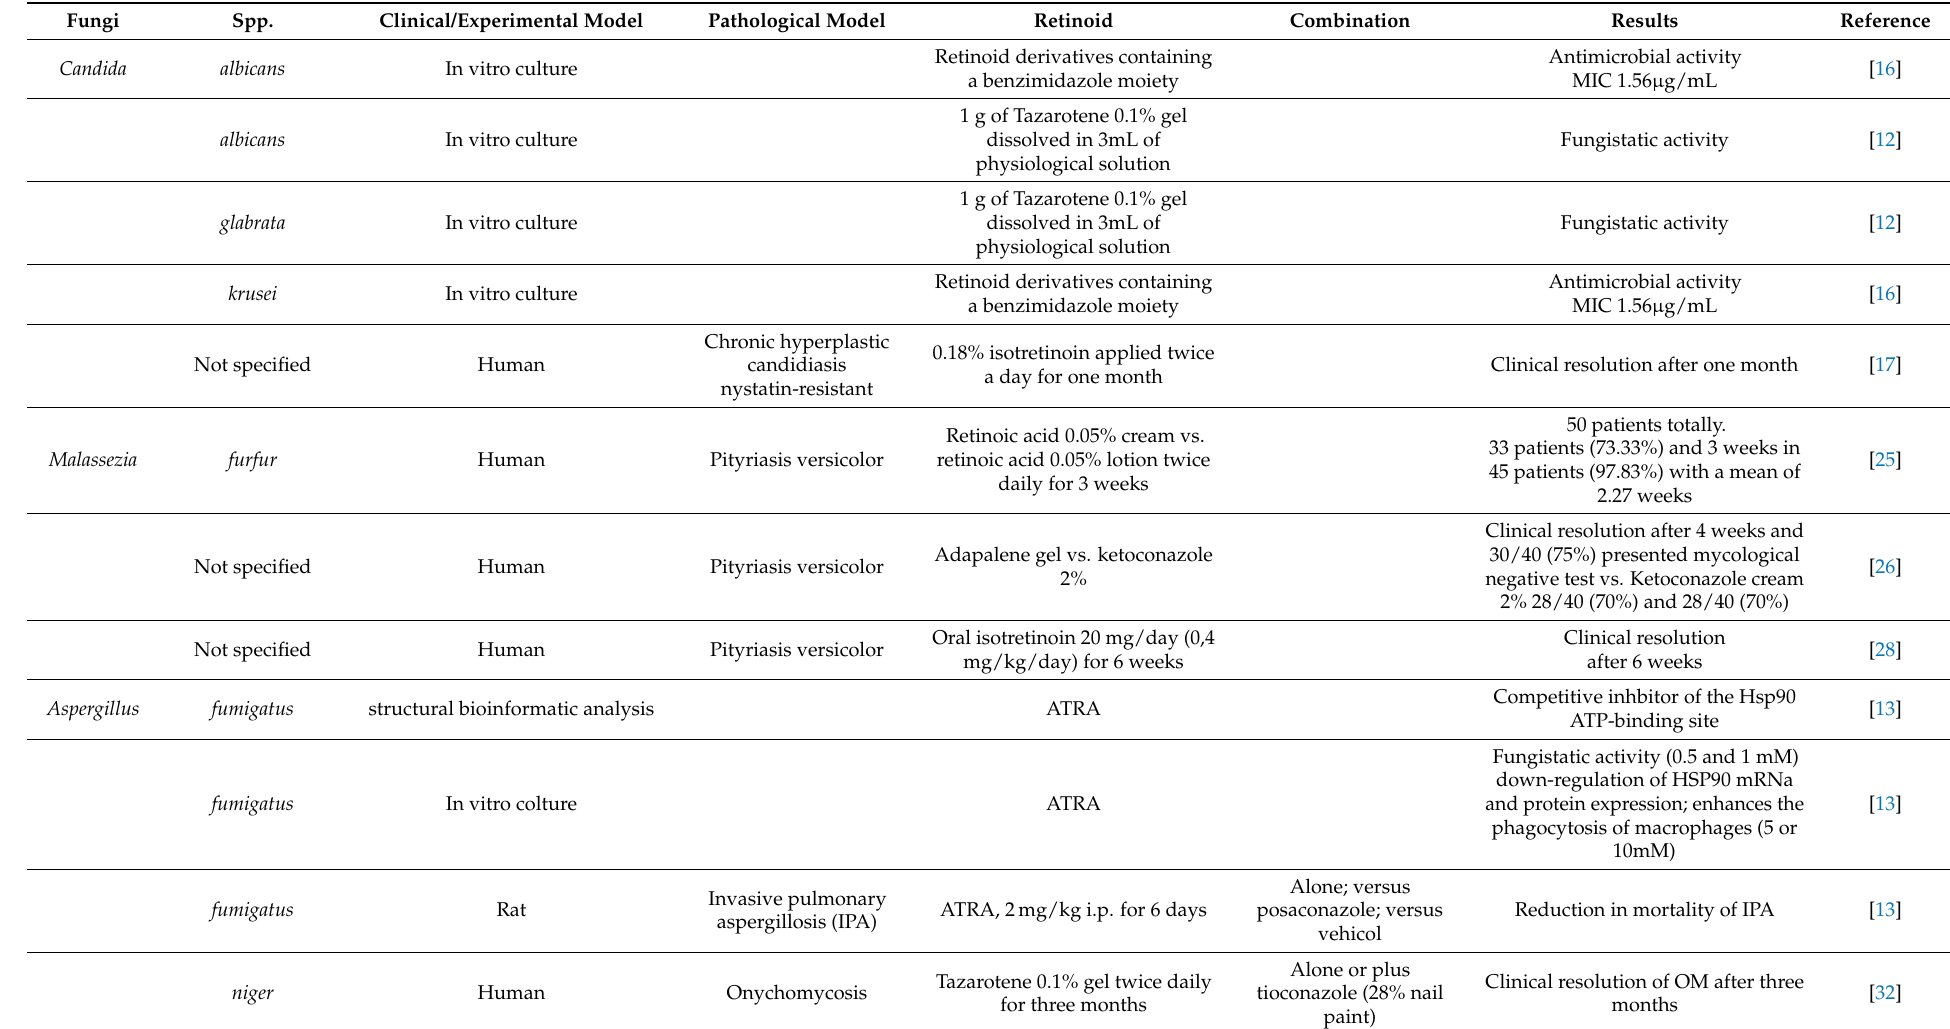
Table 1. Retinoid-based treatments against ungual